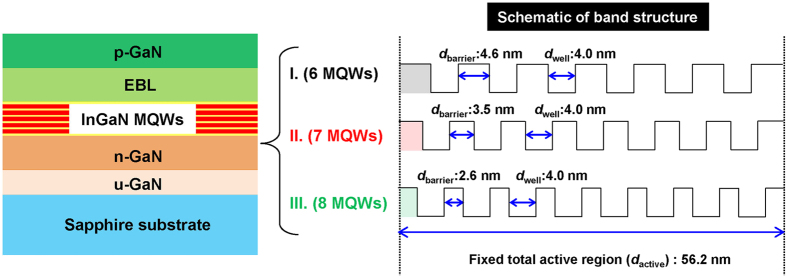
Schematic cross-section diagram of the epitaxial structure for samples I, II, and III, respectively.The dactive and dwell are fixed to 56.2 nm and 4 nm, respectively, while the Nw increases with decreasing the dbarrier.